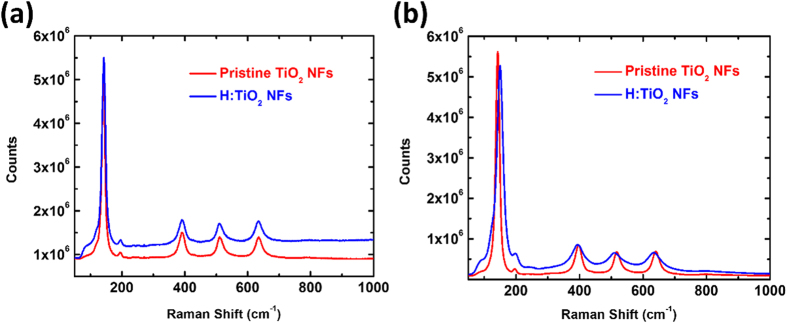
(a) 633 nm and (b) 532 nm excitation of TERS of pristine TiO2-650 NFs and H:TiO2-650 NFs.